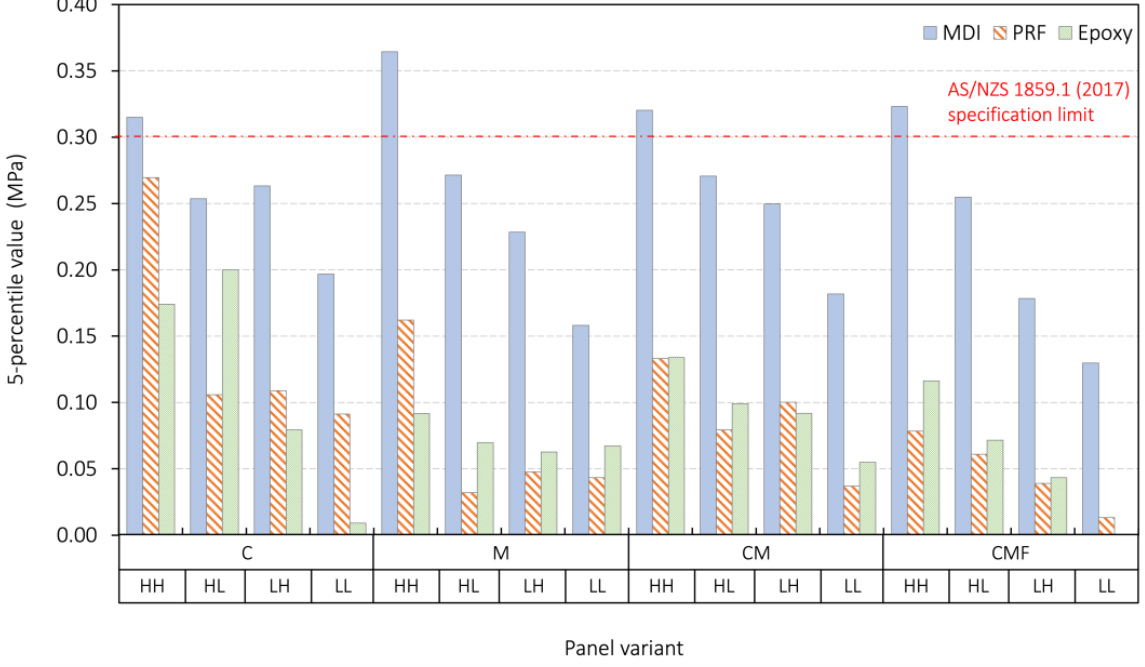
Figure 9. Comparison of 5-percentile values between panel variants of MDI, PRF and Epoxy